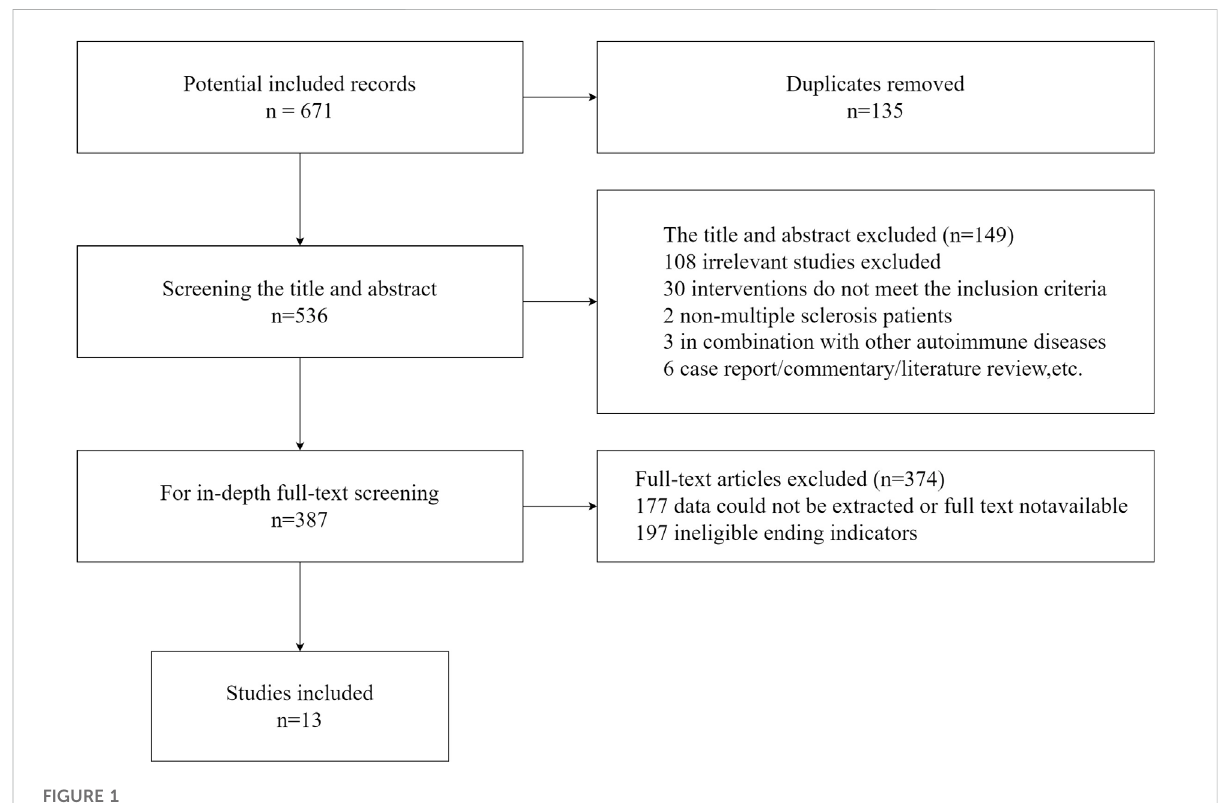
FIGURE 1 Flow graph of the literature